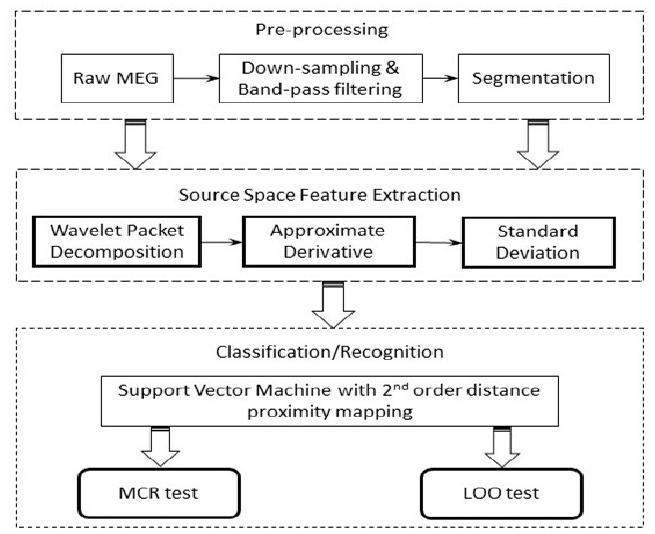
Figure 3. Workflow diagram of the proposed system.